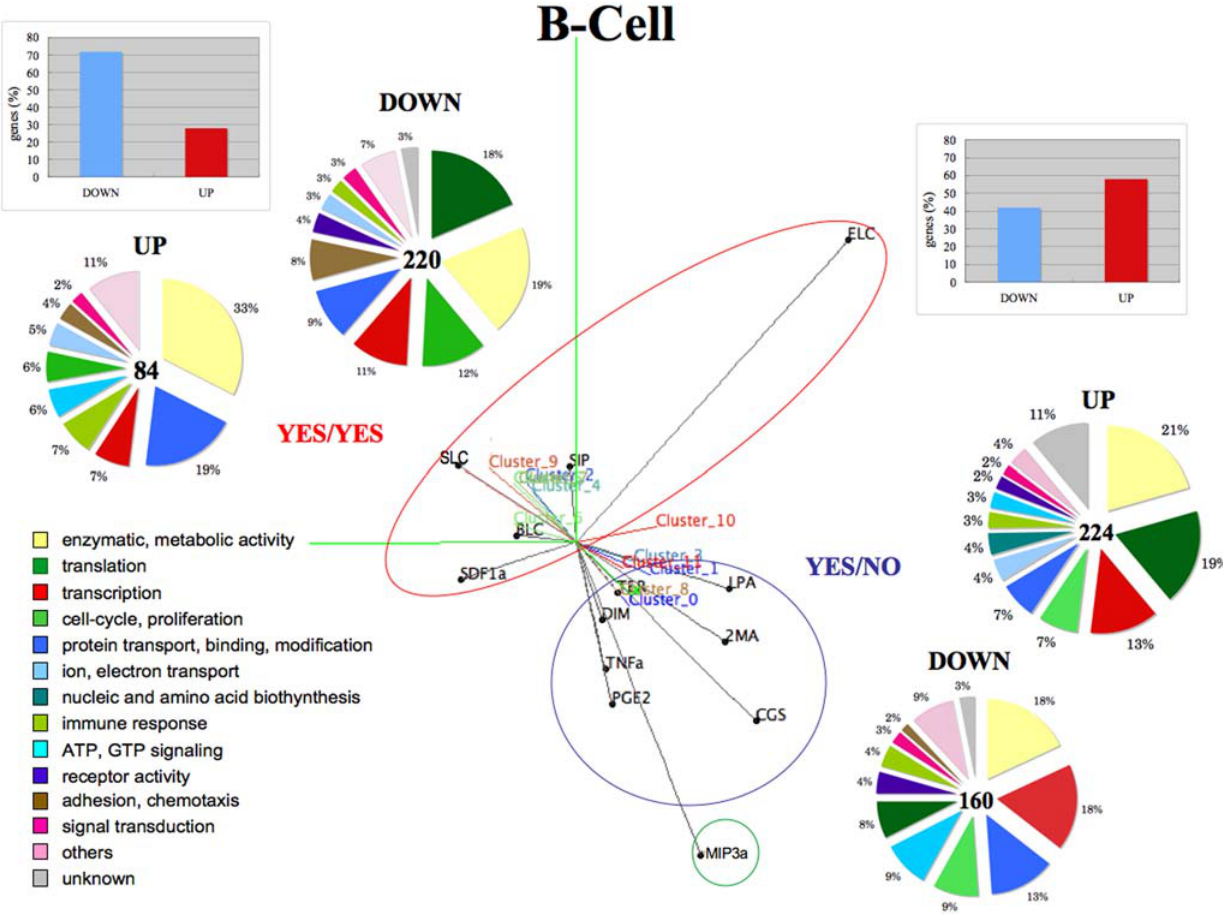
Figure 4. Clustering results for YES/NO (cAMP), YES/YES (cAMP-Ca 2 + ) and NO/YES (Ca 2 + ) groups. Ligands group into two big sub - regions: YES/NO and YES/YES and one small sub -region represented by MI3a (NO/YES) ligand. The M3A ligand mainly induced by Ca 2 + is separated and does not form a cluster downstream. This representation, which we call ‘PCA correlation ball’, shows both the groups of ligands and their correlations, and also the regulations of gene clusters from the projections of nearby ligands. Bow-graphs in the upper corners show the percent of genes being up- or down- regulated after the expiration of one/both molecules activation limited to first time marks (30 min in B-Cell), and the differences are obvious. Genes functions (‘Function’ or ‘Cellular process’ (GO terms), if ‘Function’ is absent) calculated basing on the enrichment in clusters with p-value , 0.05 are shown in the pie-graphs.